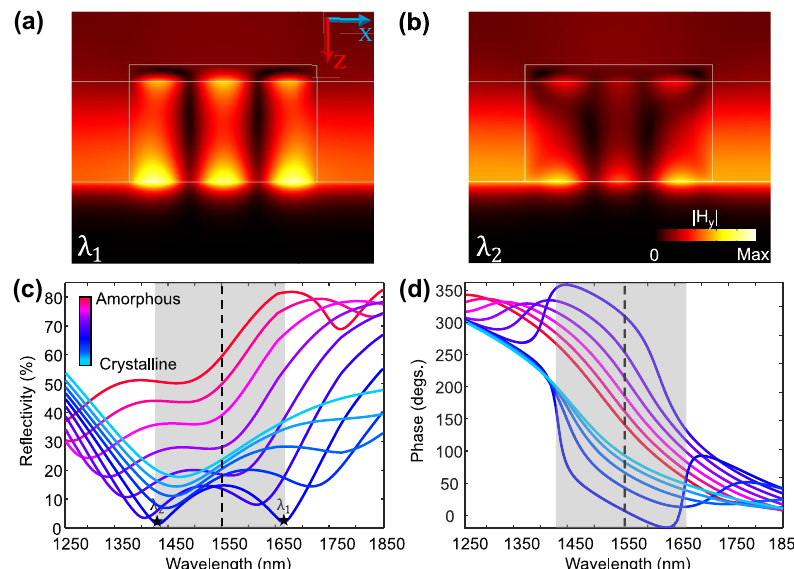
Figure 2: Reflection response of the recon- figurable metasurface in Figure 1. Magnetic field intensity profiles of the (a) SR-SPP, and (b) PR-SPP modes excited within the cross-sectional view of the meta-atom (in Figure 1(b)) with L 60 c (corresponding to 60 % crystallization fraction). (c) Reflection amplitude spectra of the metasurface in Figure 1 for several crystallization fractions. Upon partial to ultimate conversion of the phase of GST nanostripe from amorphous to ) and PR-SPP the crystalline, the SR-SPP ( 𝜆 1 )resonancewavelengthscanbegradually ( 𝜆 2 tuned resulting in different reflectivities. (d) Corresponding reflection phase spectra of the metasurface. The wavelength region in which the fundamental modes of the struc- ture interact with each other is highlighted with the gray shaded